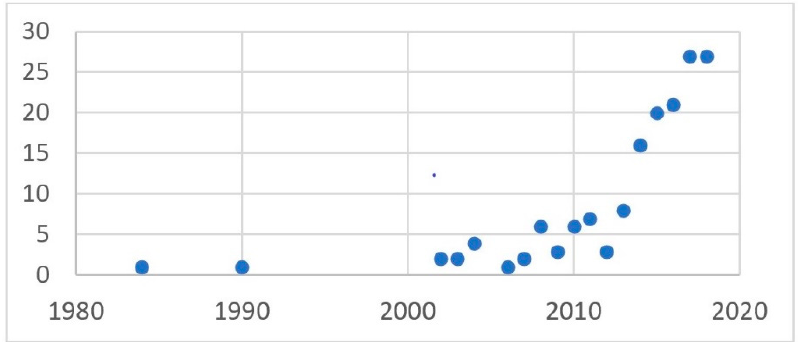
Figure 1. Number of documents per year from the database (documents from 2019 (four in total) were removed from this figure) ( n = 157 documents).